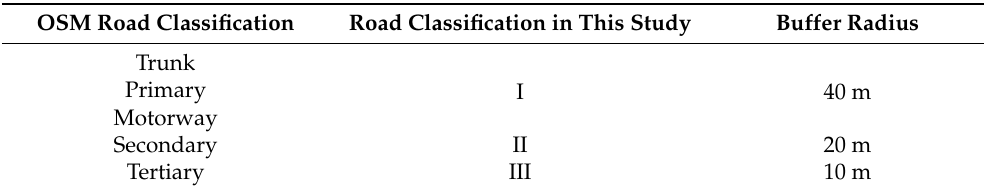
Table 1. Road classification and buffer radius